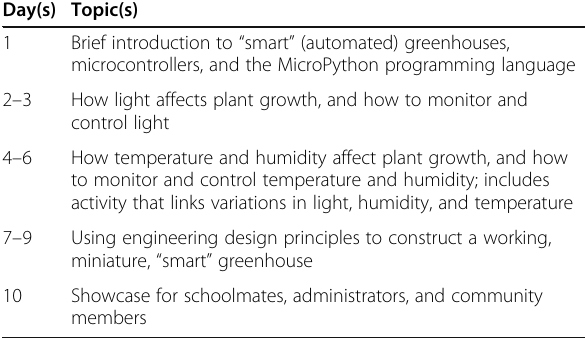
Table 2 Overview of smart-greenhouse curriculum sequence Day(s) Topic(s)